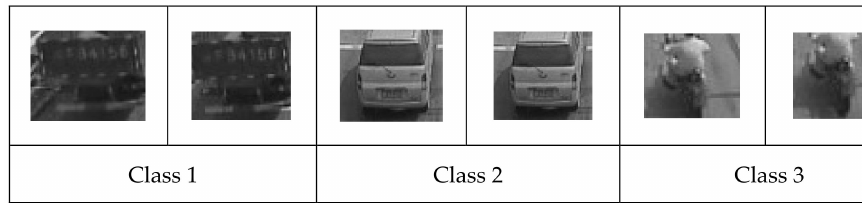
Figure 3. Positive pattern.